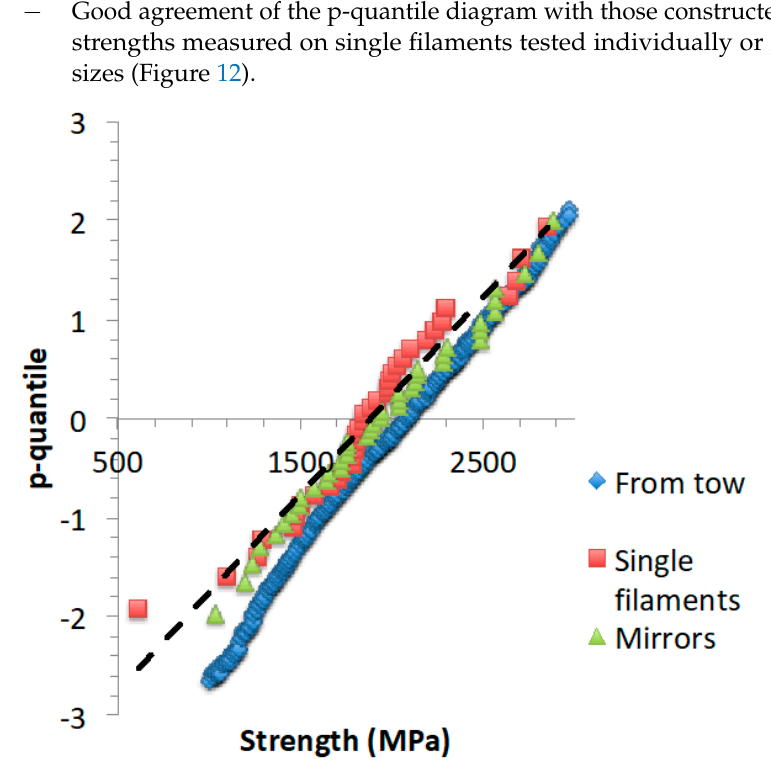
Figure 12. Comparison of p-quantile diagrams of Nicalon fibers for critical flaw strengths derived from: (i) previous p-quantile vs. strain diagrams at 115 mm gauge length for Young’s modulus = 180 GPa, (ii) tensile tests on individual filaments with 75 mm gauge length, (iii) fracture mirror radius ( r m ) measured on filaments in a tow with 75 mm gauge length and using equation σ = A √ , where A = 3.5 MPa m [49] and r m is filament radius. Therefore, on the basis of these features, it seems reasonable to consider that reliable intrinsic fracture results were obtained for the gauge length of 115 mm, and that these results could be regarded as a reference for investigations and predictions at various gauge